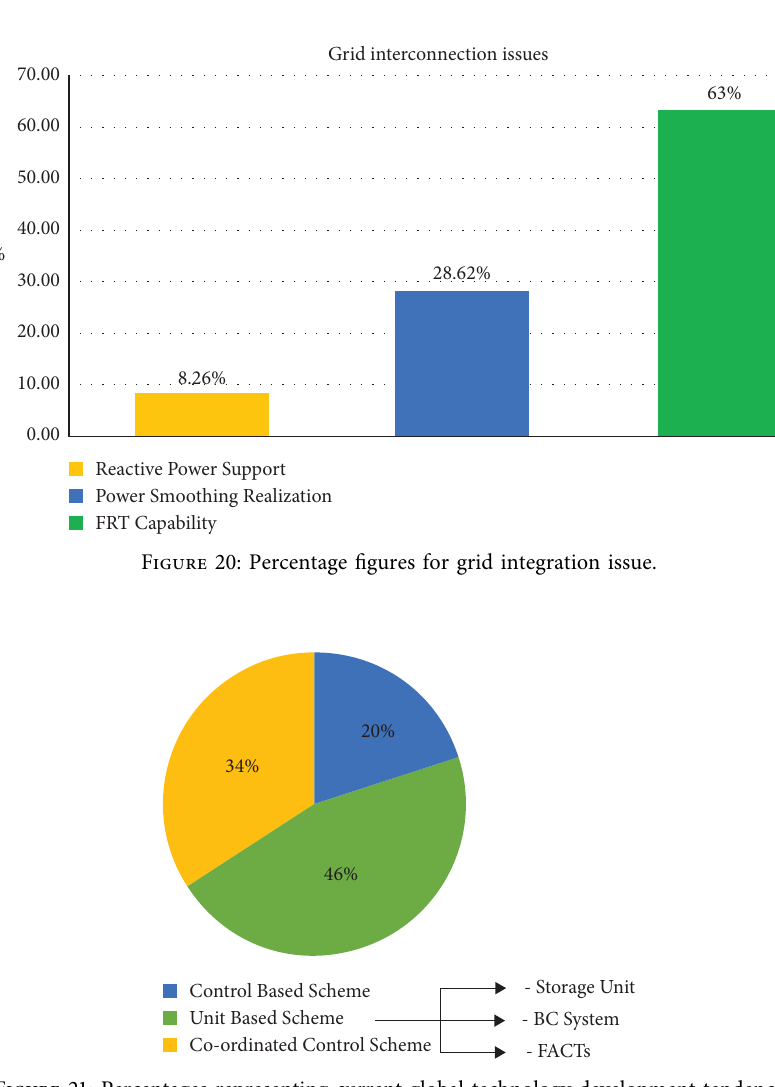
Figure 21: Percentages representing current global technology development